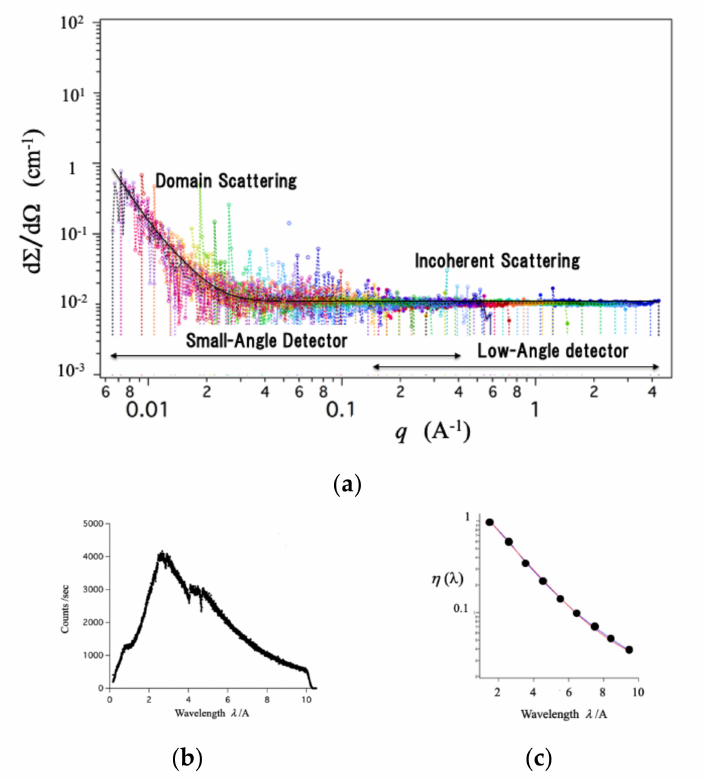
Figure 10. ( a ) Incoherent scattering obtained for vanadium standard sample, using small-angle and low-angle detectors. The di ff erent colors indicate the incoherent scattering obtained with di ff erent wavelength λ from 1 to 10 Å. ( b ) Incident flux of BL20 as a function of wavelength λ . ( c ) Counting e ffi ciency as a function of wavelength, as determined by scattering from the vanadium standard